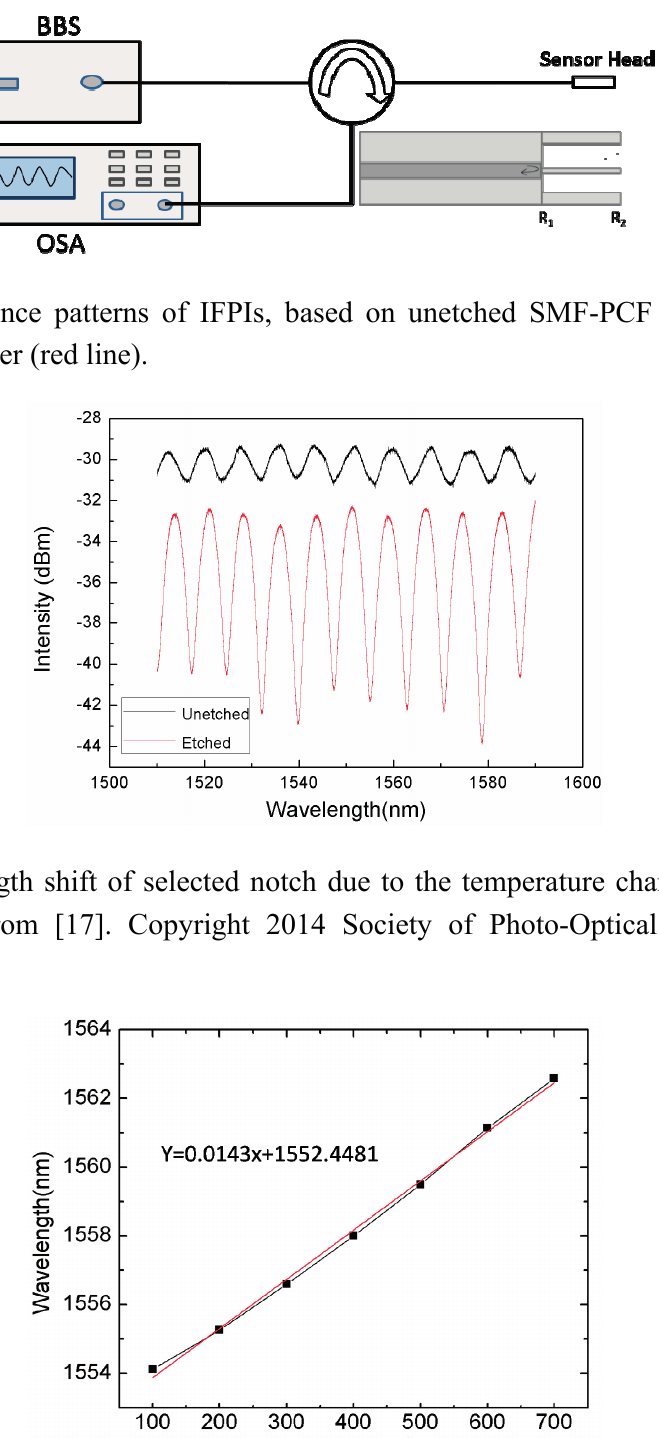
Figure 4. Experimental setup: inset is the schematic of the sensor head.